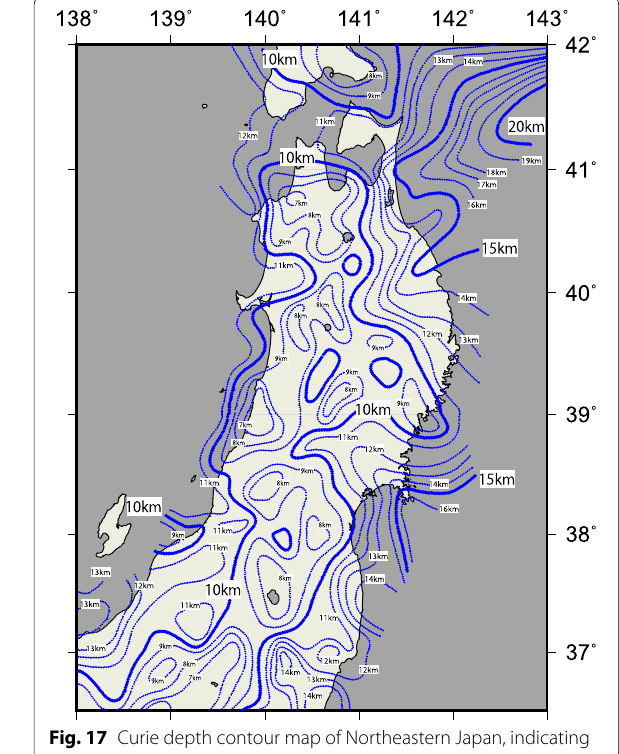
Fig. 17 Curie depth contour map of Northeastern Japan, indicating the locations of temperature measurements. Curie depth contour interval is 1 km, the contours denoting inferred Curie depths (km) below sea level. Based on Okubo et al.